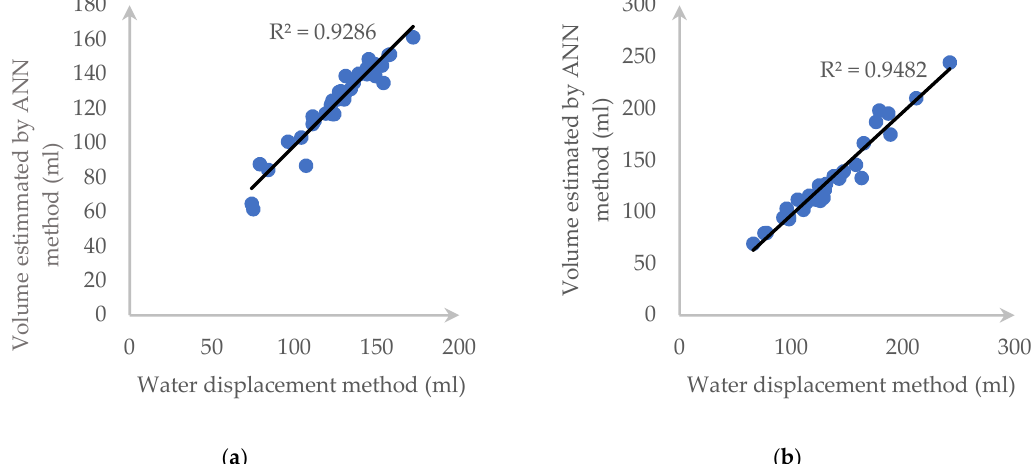
Figure 24. R 2 and correlation between ANN and the water displacement method for: ( a ) a carrot and ( b ) a cucumber.